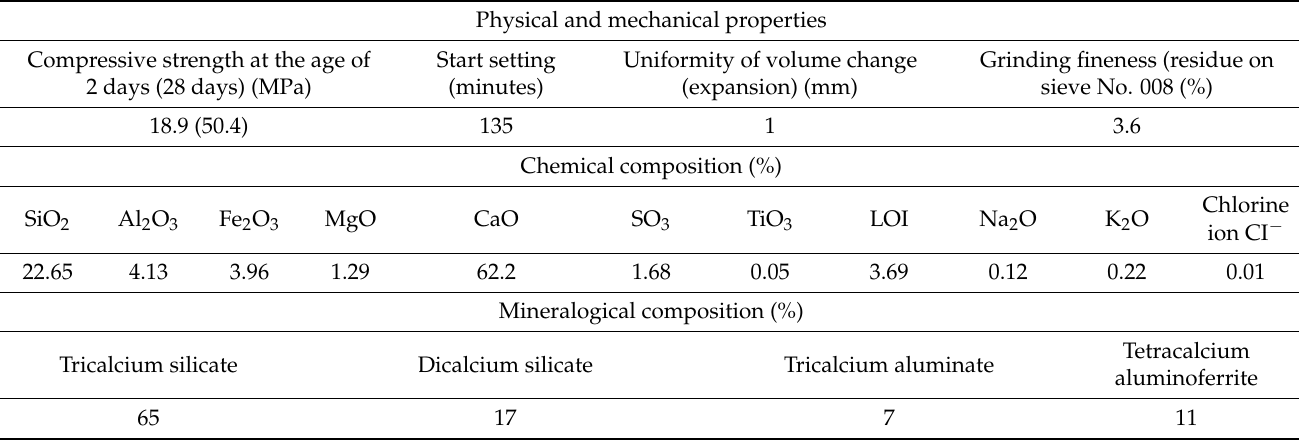
Table 1. Portland cement properties.